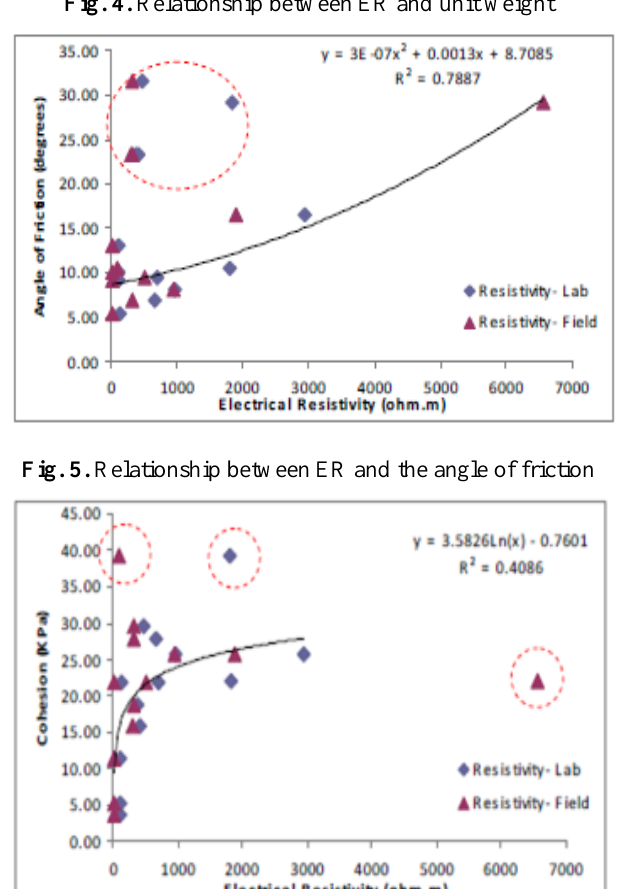
Fig. 4. Relationship between ER and unit weight